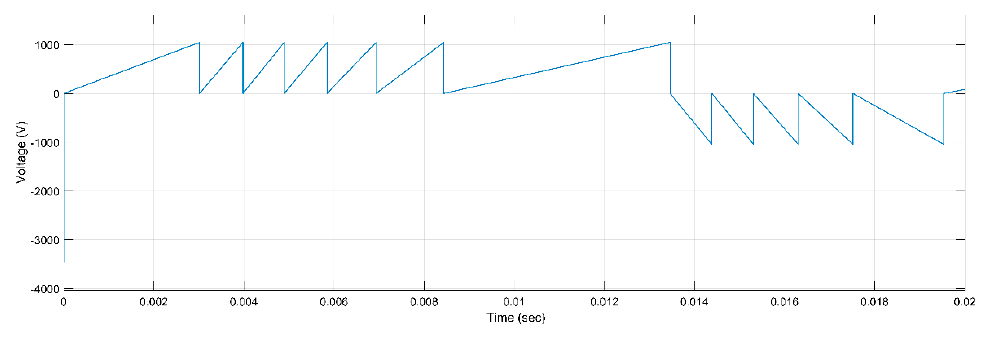
Figure 27. PD Activity for Mica, 10 kV, h, r.